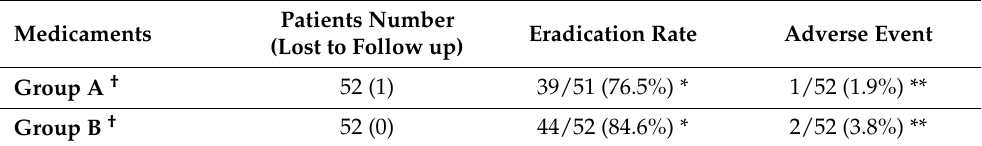
Table 3. The eradication rate and adverse event of ILTHPI.